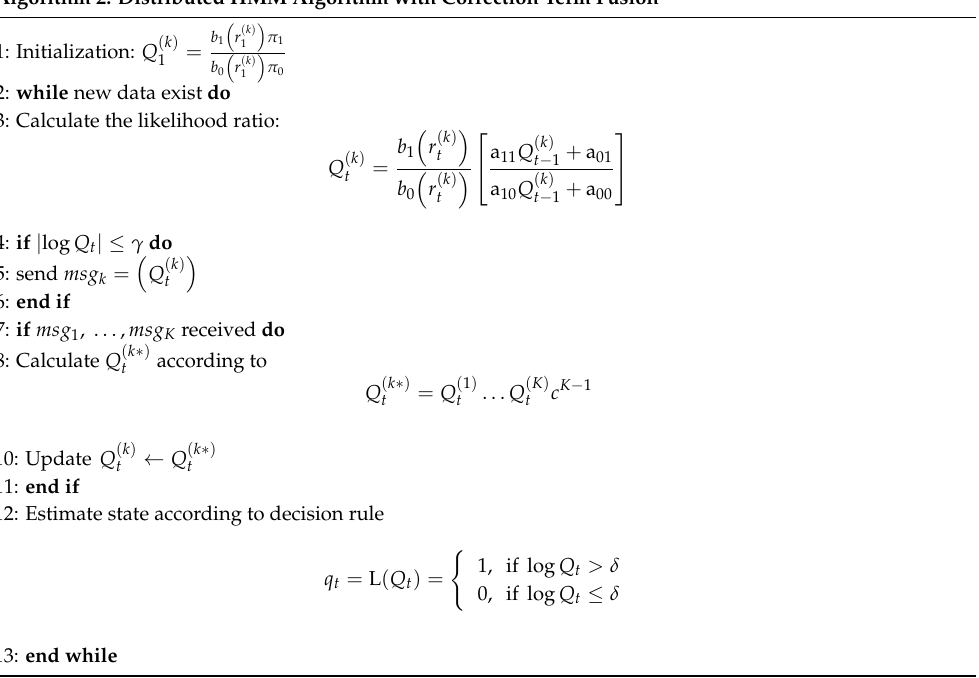
Algorithm 2: Distributed HMM Algorithm with Correction Term Fusion